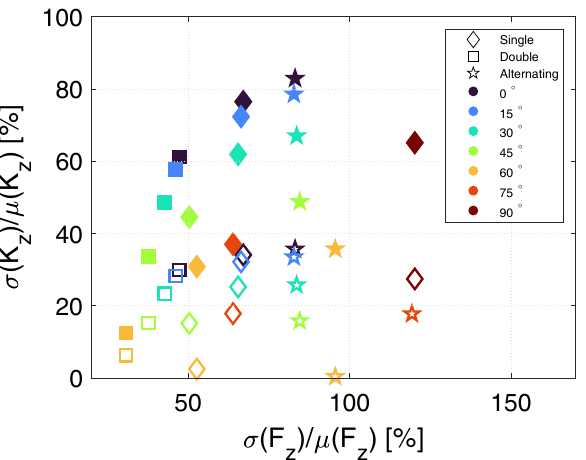
Figure 8. The relative standard deviation of the stiffness in the z -direction in percent as function of the relative standard deviation of the force in the z -direction in percent. The filled symbols consider the full z − z 0 -range from 0 to 3 mm, while the unfilled symbols consider only the z − z 0 -range from 0 to 1 mm. Only bearings which are stable in the z -direction, i.e. have K z > 0 over the z -range considered, are